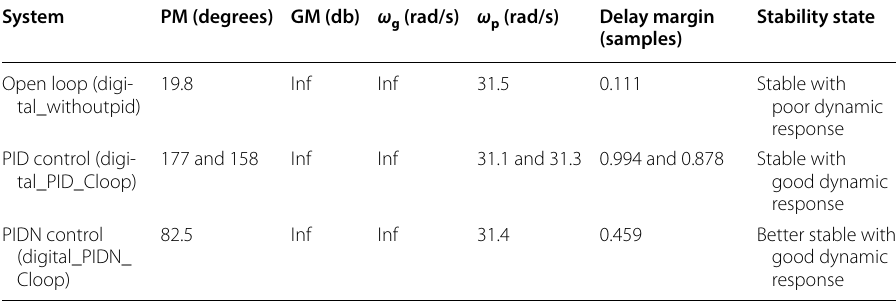
Table 4 Comparison of stability analysis in digital domain of BBC in boost mode of operation